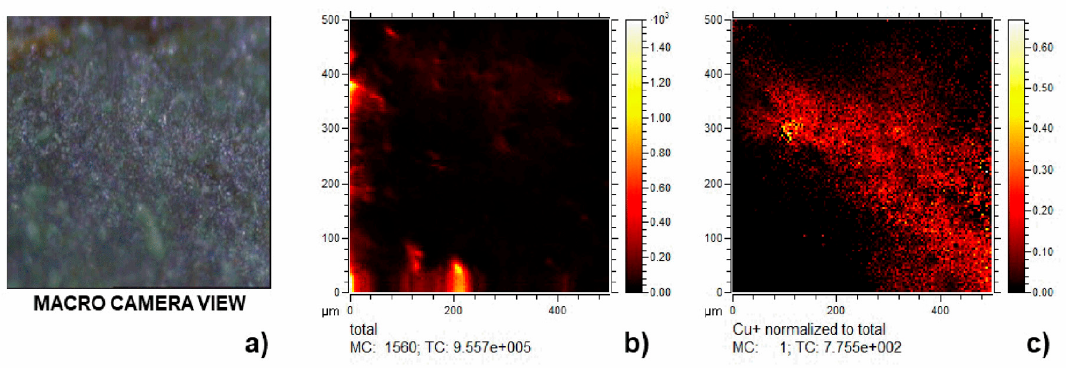
Figure 9. ToF-SIMS ion images are recorded in the positive ion mode in the green area. ( a ) Macro camera view of the area where ToF-SIMS images were acquired (area of 500 µ m × 500 µ m), ( b ) total ion image, and ( c ) ion image of the copper ion (Cu + , m / z 63).